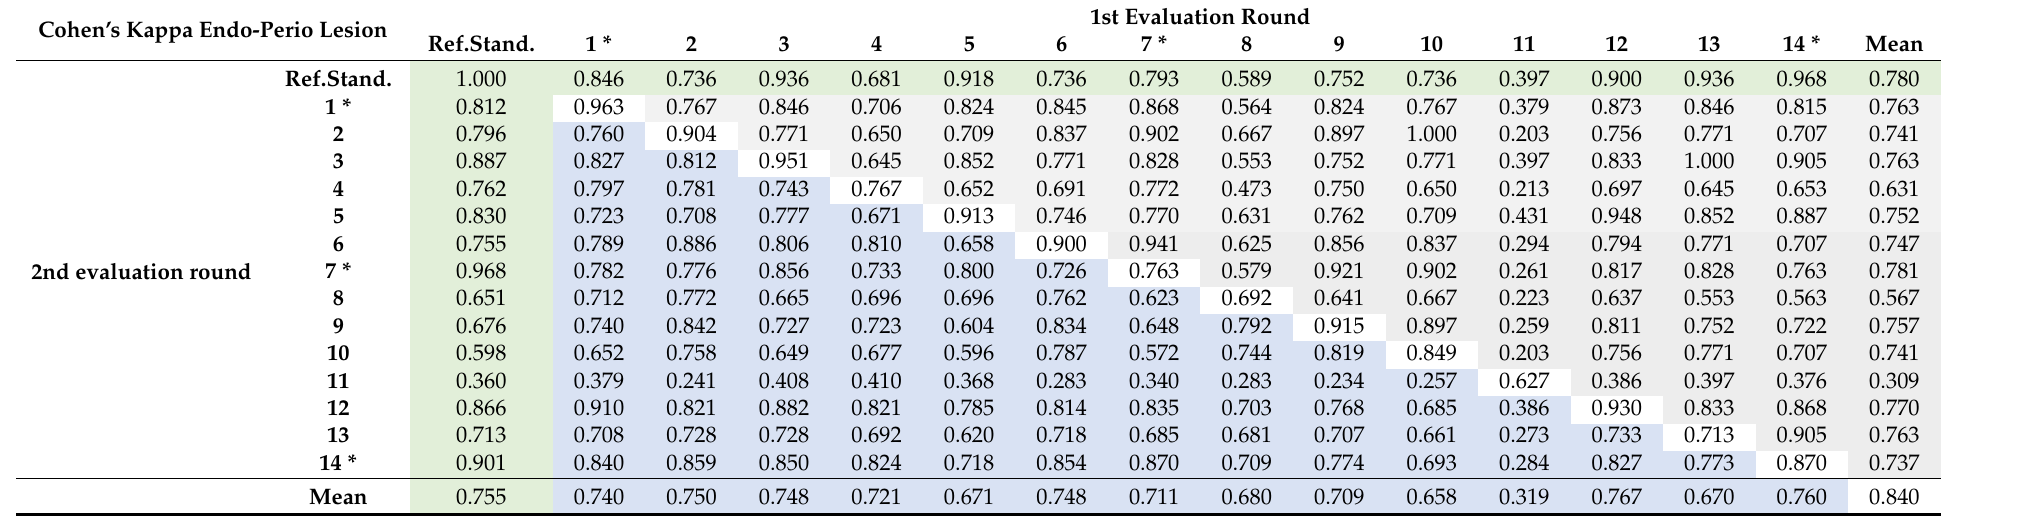
Table 4. Values of inter- and intra-rater reliability for the detection of endo-perio lesions which was calculated among all dentists (N = 14) and in relation to the reference standard (green coloured boxes). Grey coloured boxes illustrate inter-rater CK values of the first assessment and blue coloured boxes for the second assessment. White fields indicate intra-rater CK